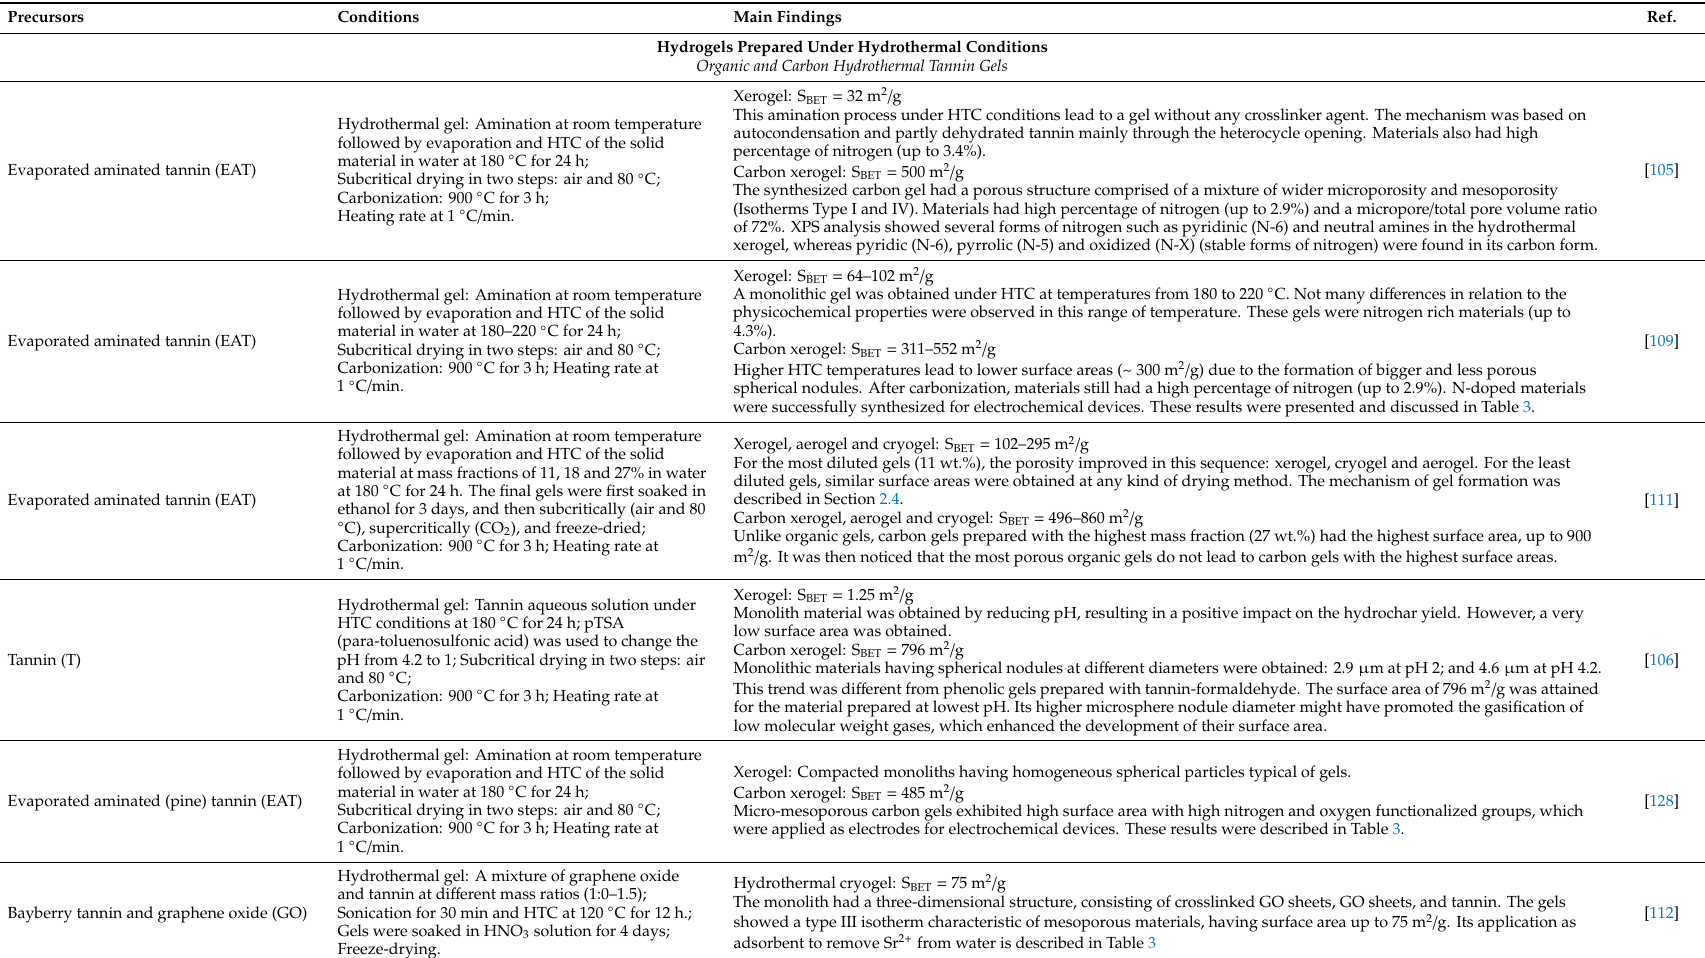
Table 2. Organic and carbon tannin gels synthesized under hydrothermal